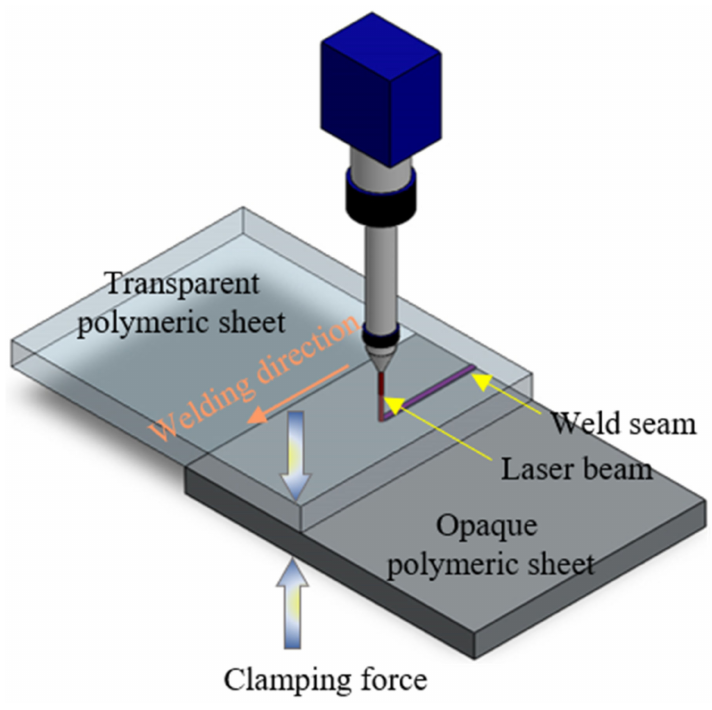
Figure 1. Experimental setup. Table 1. Mechanical and thermophysical properties of PC and